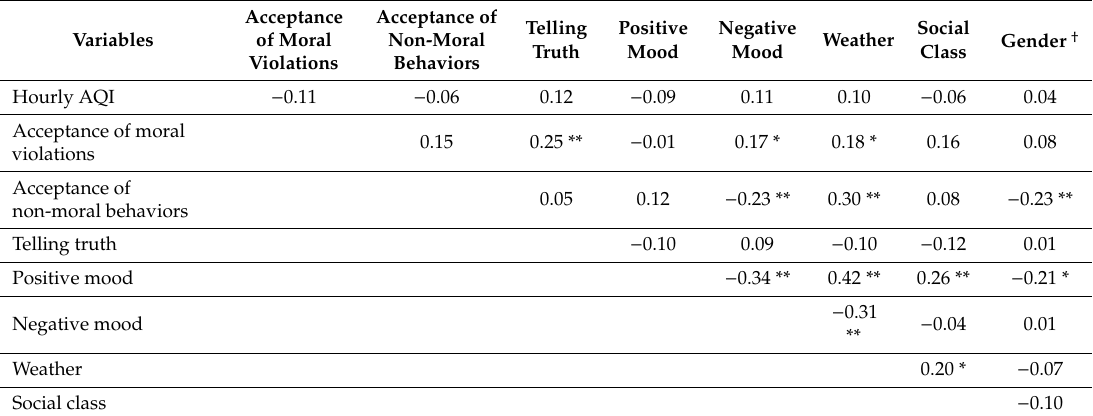
Table 1. The correlations of variables used in Study